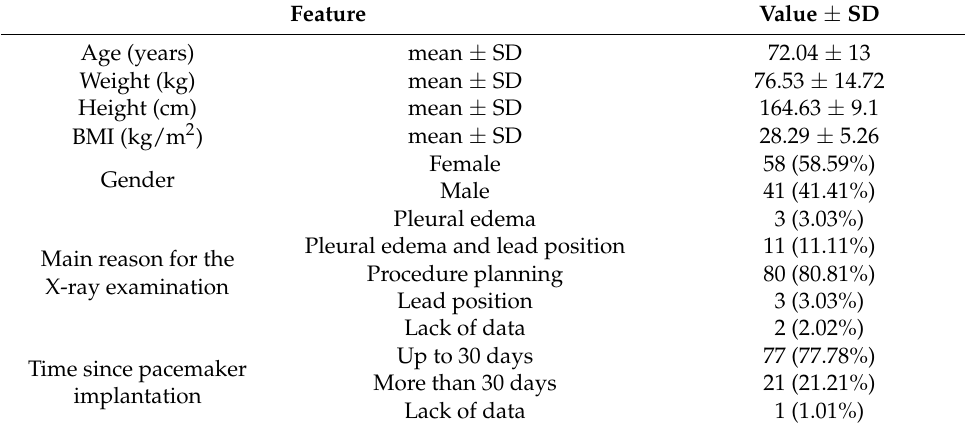
Table 2. Characteristics of the patients